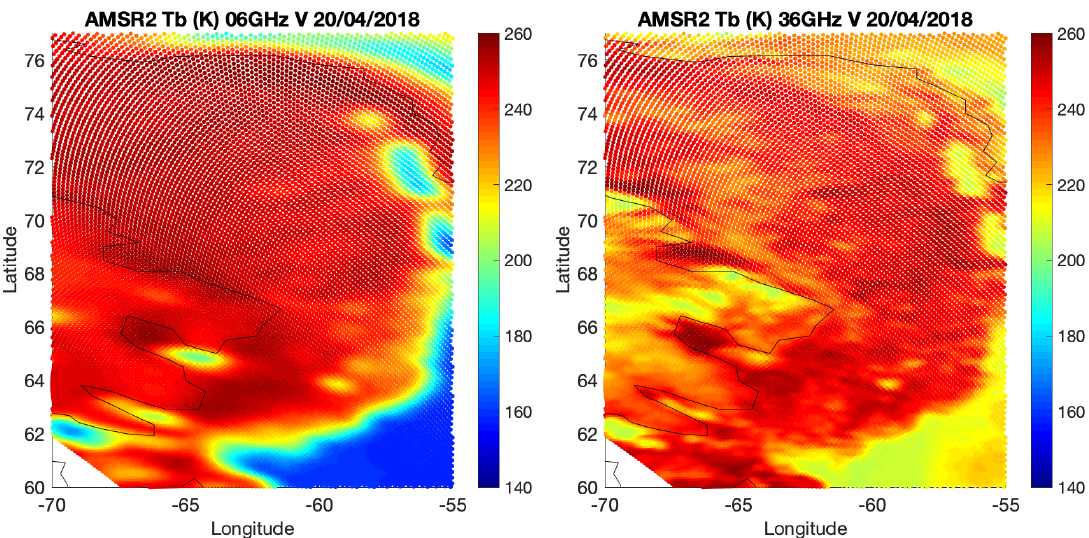
Figure 2. The AMSR2 data for the selected scene, 20 April 2018. Left: the 6 GHz vertical polarization (at its nominal spatial resolution). Right: the 36 GHz vertical polarization (at the 18 GHz spatial